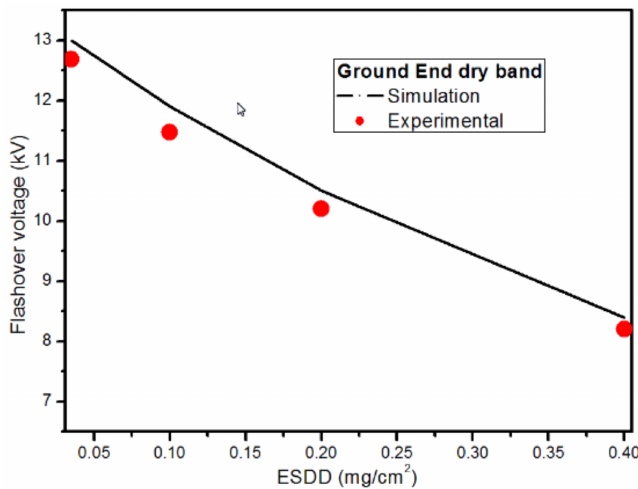
Figure 19. Flashover voltage for different values of ESDD for a dry band located near the ground